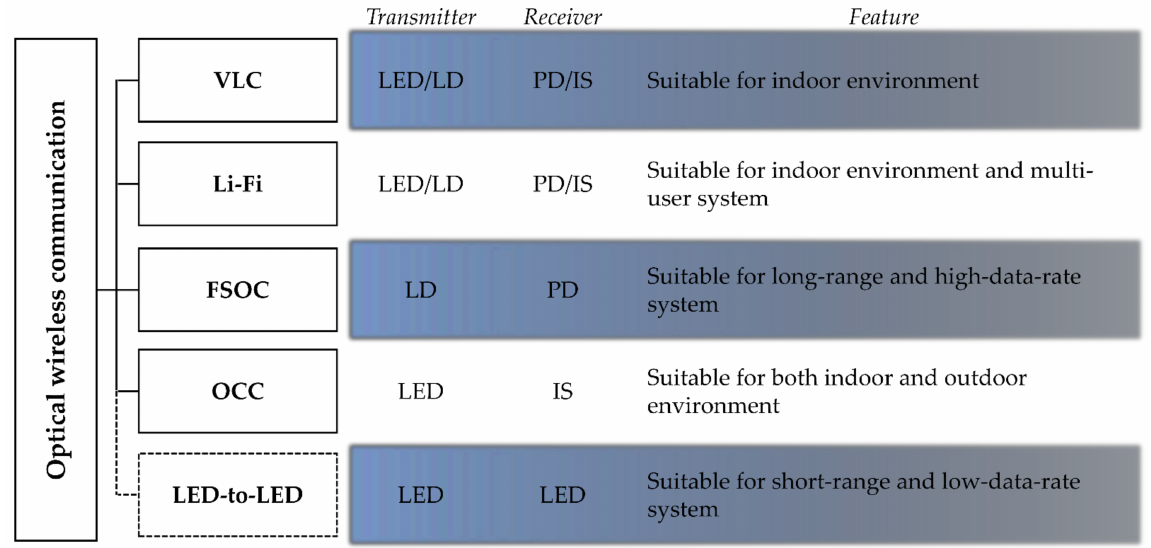
Figure 1. Subcategories of optical wireless